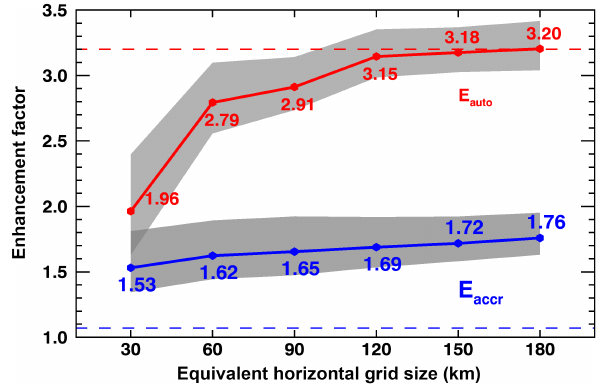
Figure 4. Autoconversion (red line) and accretion (blue line) en- hancement factors as a function of equivalent sizes. The shaded ar- eas are calculated by varying q c and q r within their retrieval uncer- tainties. The two dashed lines show the constant values of autocon- version (3.2) and accretion (1.07) enhancement factors prescribed in